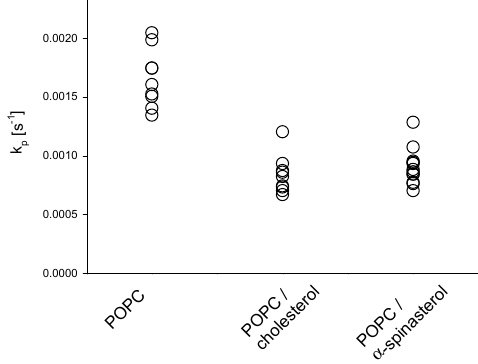
Figure 3. Rate constants (k p ) for the permeation of dithionite across large unilamellar vesicle (LUV) membranes composed of POPC in the absence and in the presence of 20 mol % cholesterol or α -spinasterol at 37 °C. All single values of the rate constant are shown which were determined from two independent samples each threefold measured.